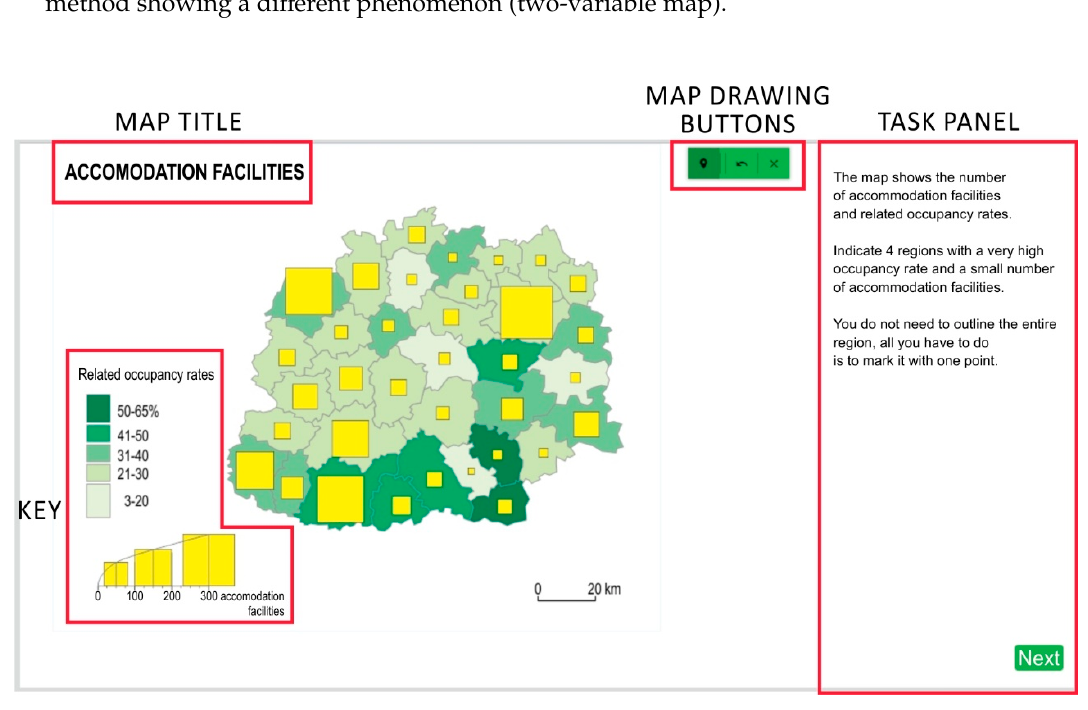
Figure 3. The main window of the application used by the study participants. The map title and legend were on the left side of the window, while the buttons with tools for identifying points and drawing polygons were in the upper right corner of the map window. On the right was a task panel in which the participants provided their answers.